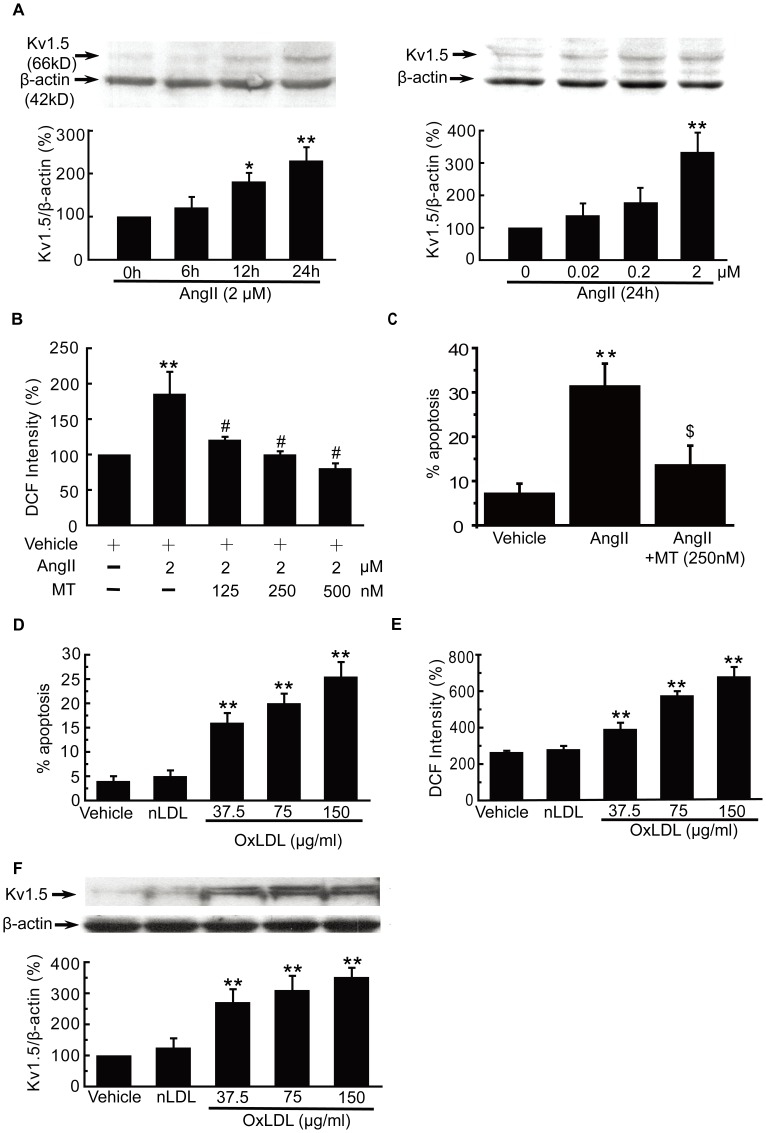
Ang II and oxLDL affected Kv1.5 protein expression, intracellular ROS production, and endothelial cell injury.HUVECs were incubated with AngII at different concentrations for different times. Ang II time (A)- or concentration (B)-dependently enhanced the Kv1.5 protein expression. Pretreatment with MT for 30 min inhibited Ang II (2 µM, 24 h)-induced increase in intracellular ROS levels in HUVECs in a concentration-dependent manner (C), as determined by DCF fluorescence. MT also significantly attenuated Ang II (2 µM, 24 h)-induced HUVEC injury. Incubation of HPAECs with oxLDL at the concentration of 37.5, 75 and 150 µg/ml significantly increased EC injury (D), intracellular ROS production (E) and Kv1.5 protein expression (F) in a concentration-dependent manner. The values were presented as ± SEM of 6 independent experiments for Ang II- or oxLDL-treatment, respectively. * P<0.05, ** P<0.01 vs. control; $ P<0.05, # P<0.01 vs. Ang II group.